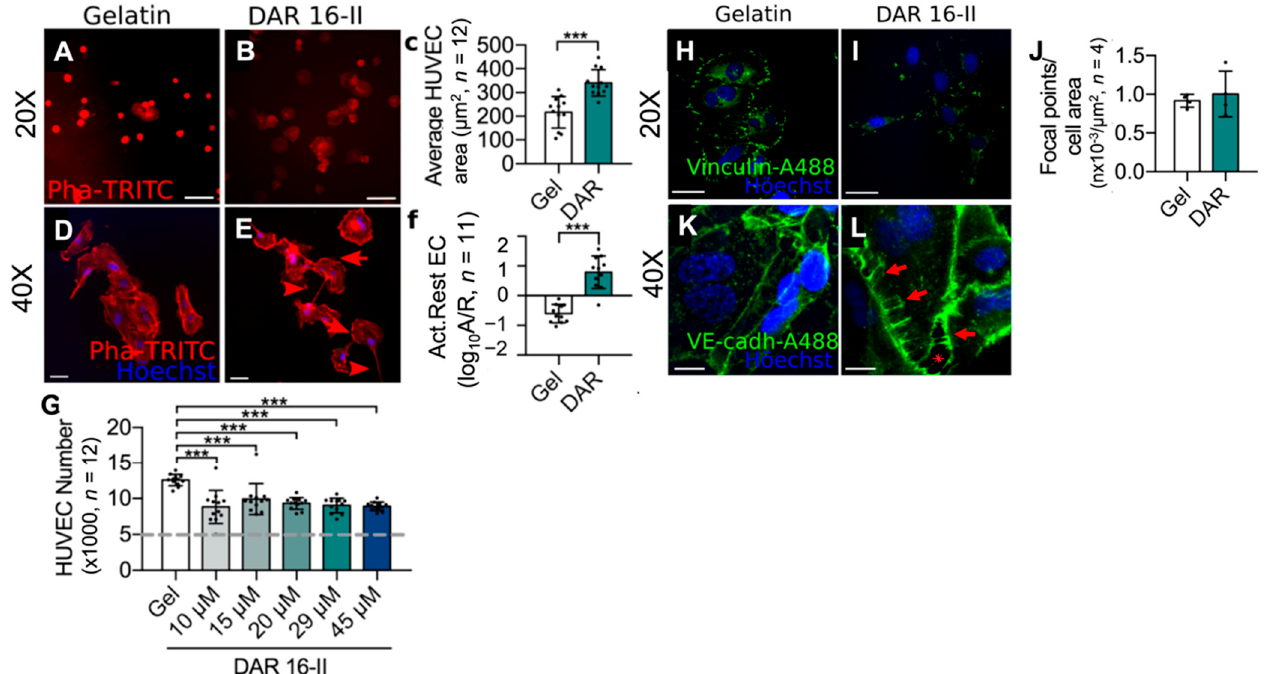
Figure 1. HUVEC are activated on exposure to DAR 16-II. ( A , B ) Representative images (Pha staining, 20× OM, scale-bars= 30 µm) of HUVEC cultured in the presence or absence of DAR 16-II at 30 min post seeding; ( C ) evaluation of cells’ average area; ( D , E ) representative images (Pha Staining, 40× OM, scale-bars= 30 µm) of HUVEC grown on gelatin or DAR 16-II. Dar-16-II induces morphological changes, i.e., the presence of filopodia (red arrow) and lamellipodia (red arrowhead) is suggestive of an activated, migratory phenotype; ( F ) quantification of the ratio between “activated” and “quiescent” HUVEC; ( G ) proliferation of HUVEC (24 h) when cultured in different concentrations of DAR 16-II or gelatin as control (the grey dashed line indicates the input number of HUVEC = 5 × 10 3 ); ( H , I ) representative pictures (Vinculin immuno-staining, 20× OM, scale-bars = 30 µm) demonstrating the re-distribution of focal adhesions in HUVEC seeded in the presence of DAR16-II when compared to the control; ( J ) quantification of vinculin-positive foci per cell area; ( K , L ) representative images (VE-Cadherin immuno-staining, 40× OM, scale-bars = 10 µm) showing inter-endothelial junctions of HUVEC monolayers grown on DAR 16-II or gelatin. HUVEC cultured on DAR 16-II display interdigitating junctions (red arrows) with discontinuities (red asterisk). *** p < 0.05